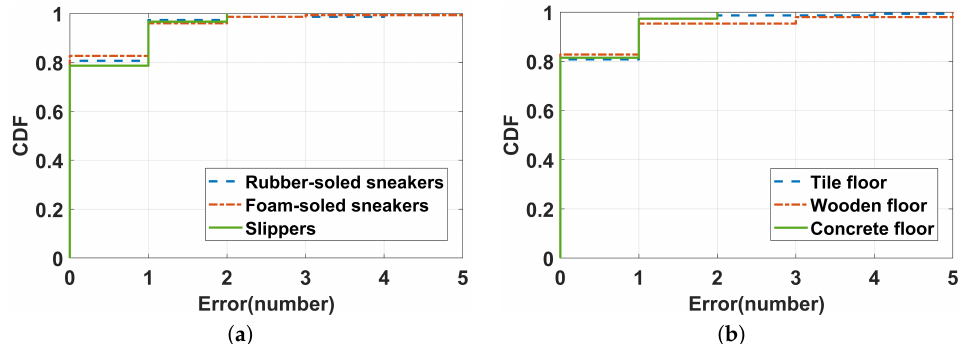
Figure 10. CDF of counting errors with various footwear ( a ) (Performances for different footwear) and floor material ( b ) (Performances on different floor materials).